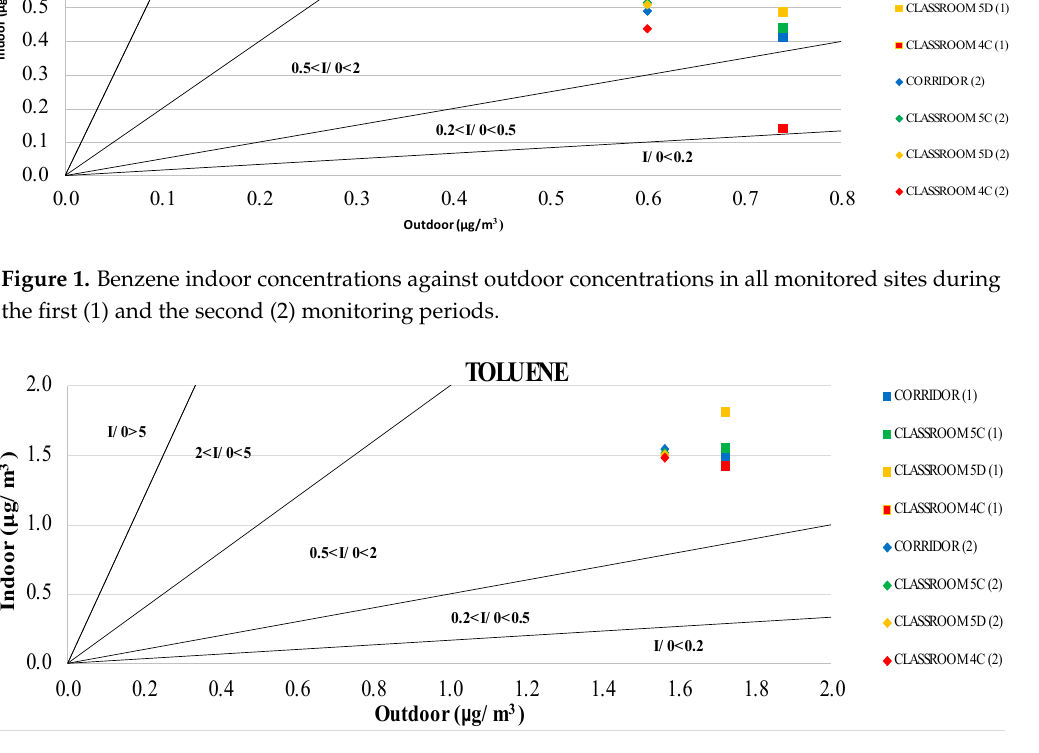
Figure 2. Toluene indoor concentrations against outdoor concentrations in all monitored sites during the first (1) and the second (2) monitoring periods.